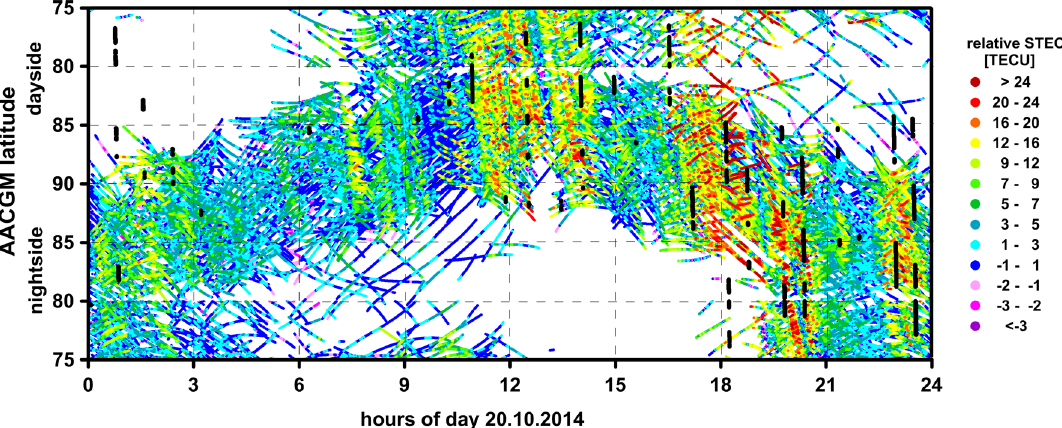
Fig. 7. The temporal changes of relative STEC values observed on day- and night-side ionosphere on 20 October 2014. Black dots correspond to results of PCP project with foreground/background density ratio higher